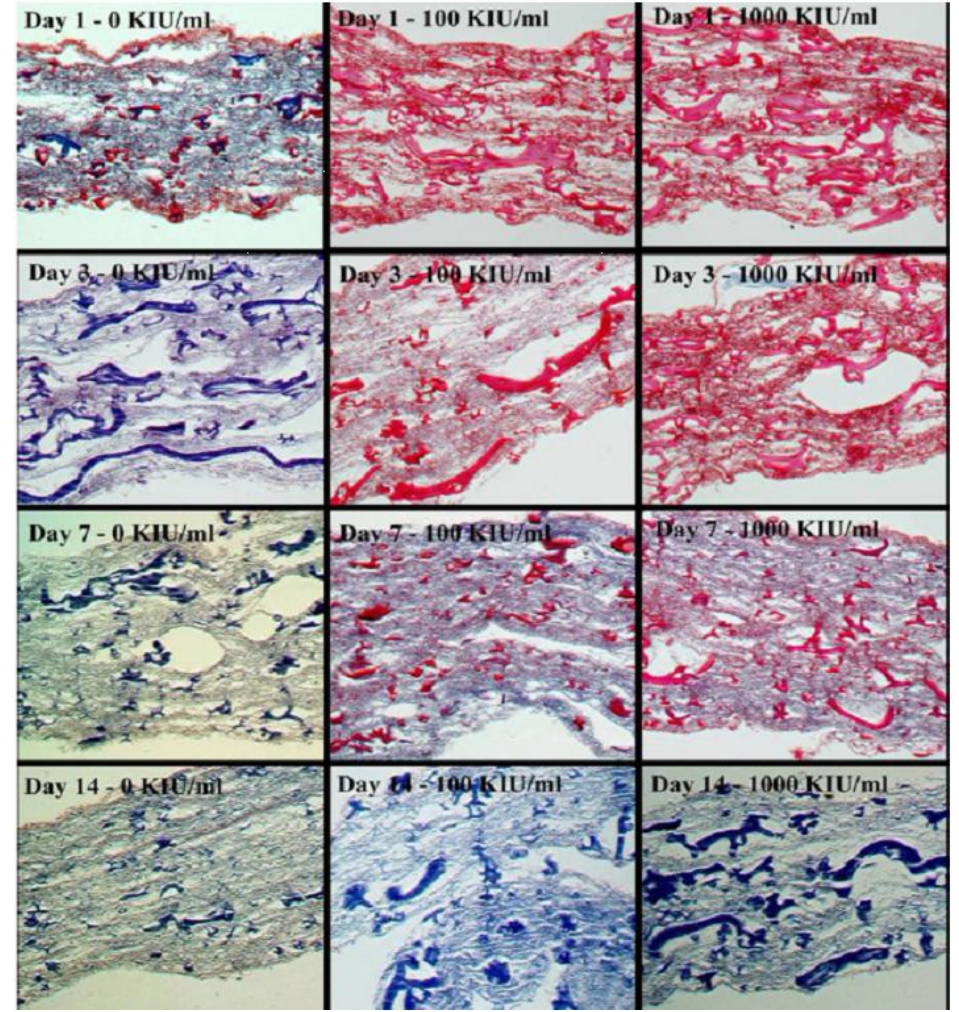
Figure 7. Optical micrographs of trichrome histology demonstrated the remodeling of fibrinogen and the production of new collagen matrix in electrospun fibrinogen scaffolds seeded with hBSMs. Scaffolds contained increasing amounts of aprotinin from left to right. Images at 20×. Reproduced with permission from IOP Publishing Ltd.